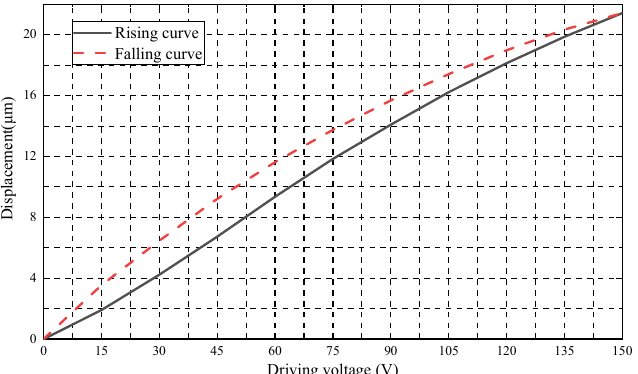
Figure 3. Piezoelectric characteristic curve.